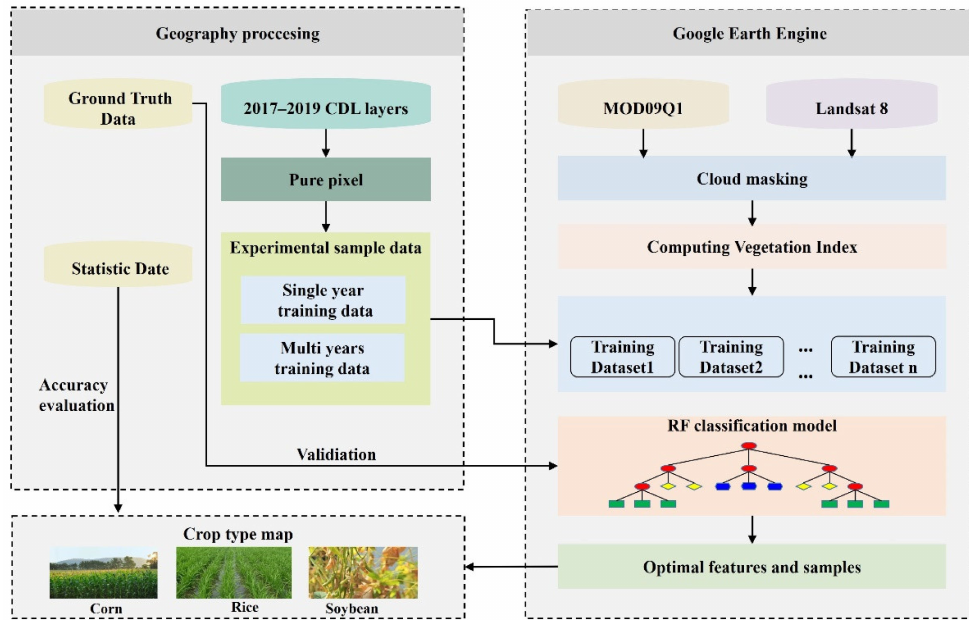
Figure 3. The workflow for mapping crop-type fields by time series Landsat and Modis